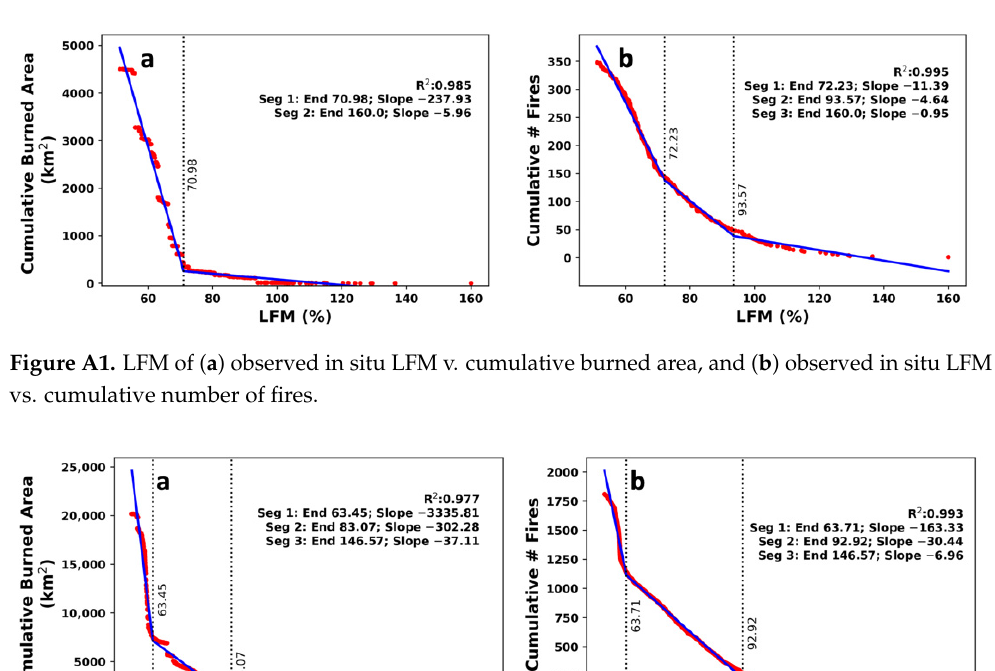
size were not appropriate.